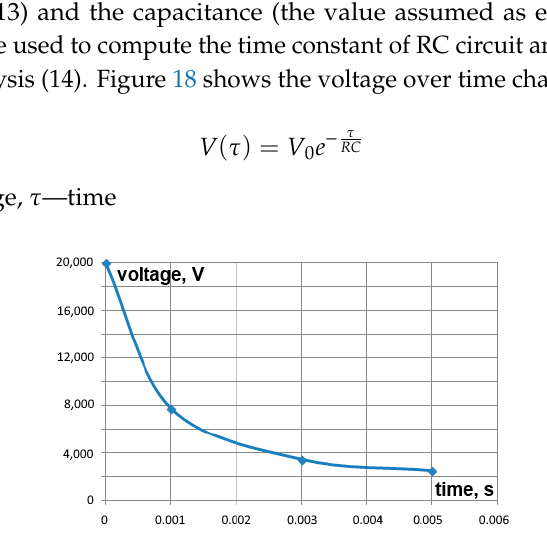
Figure 18. The voltage course during the simulated discharge.